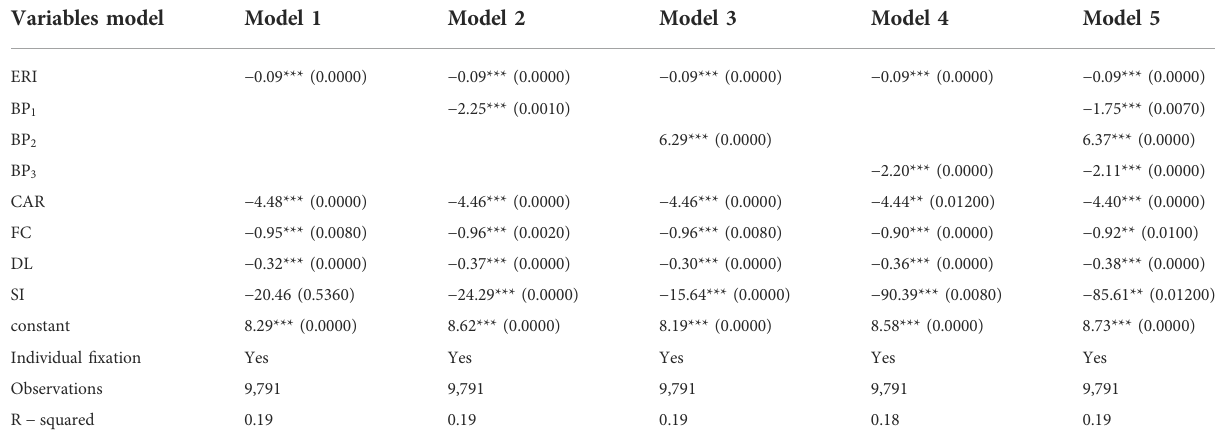
TABLE 6 Regression results of Taiwan-funded technology-intensive